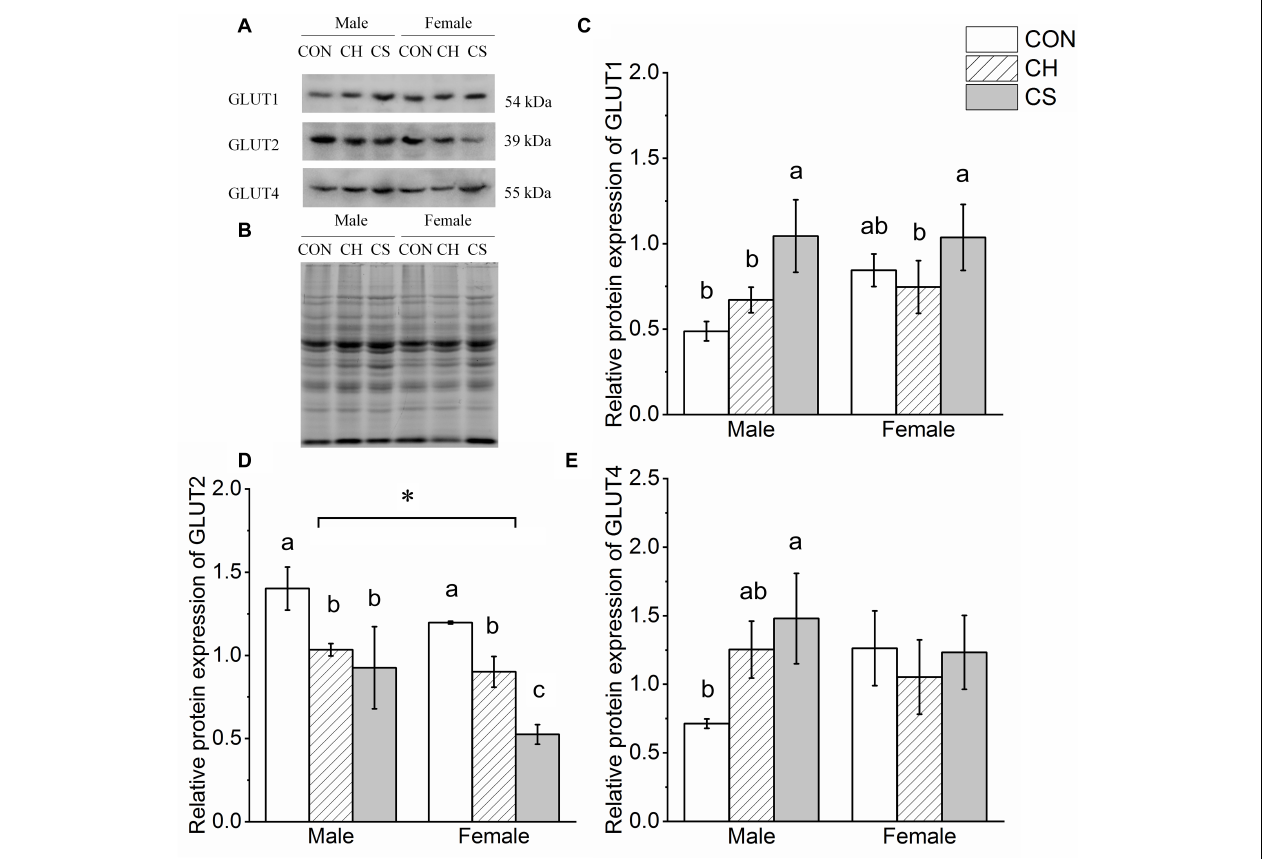
FIGURE 7 | Changes in protein expression levels of glucose transporter proteins in cardiac muscle of Brandt’s voles. (A) Representative immunoblots of GLUT1, GLUT2, and GLUT4 in cardiac muscle. (B) Representative polyacrylamide gel of total protein. (C) Relative protein expression of GLUT1. (D) Relative protein expression of GLUT2. (E) Relative protein expression of GLUT4. Values are mean ± SD. n = 8. CON, control group; CH, cool huddling group; CS, cool separated group. Different letters identify statistically significant differences among temperature treatment groups ( P <